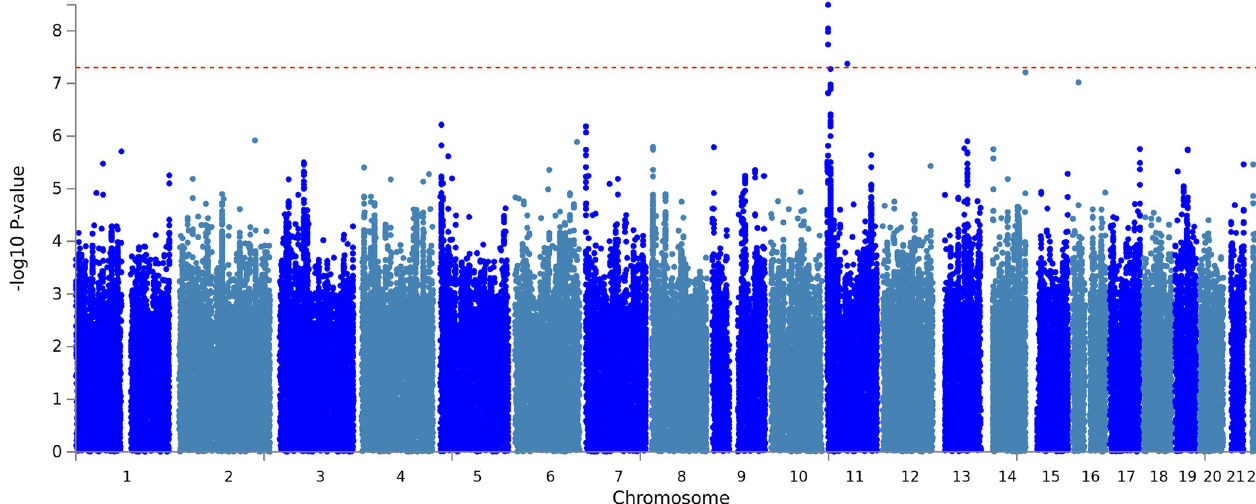
Fig 2. Manhattan plot. Manhattan plot of -log 10 p values vs SNP position for single SNP analysis. SNPs above the red horizontal line indicate genome-wide significant findings.